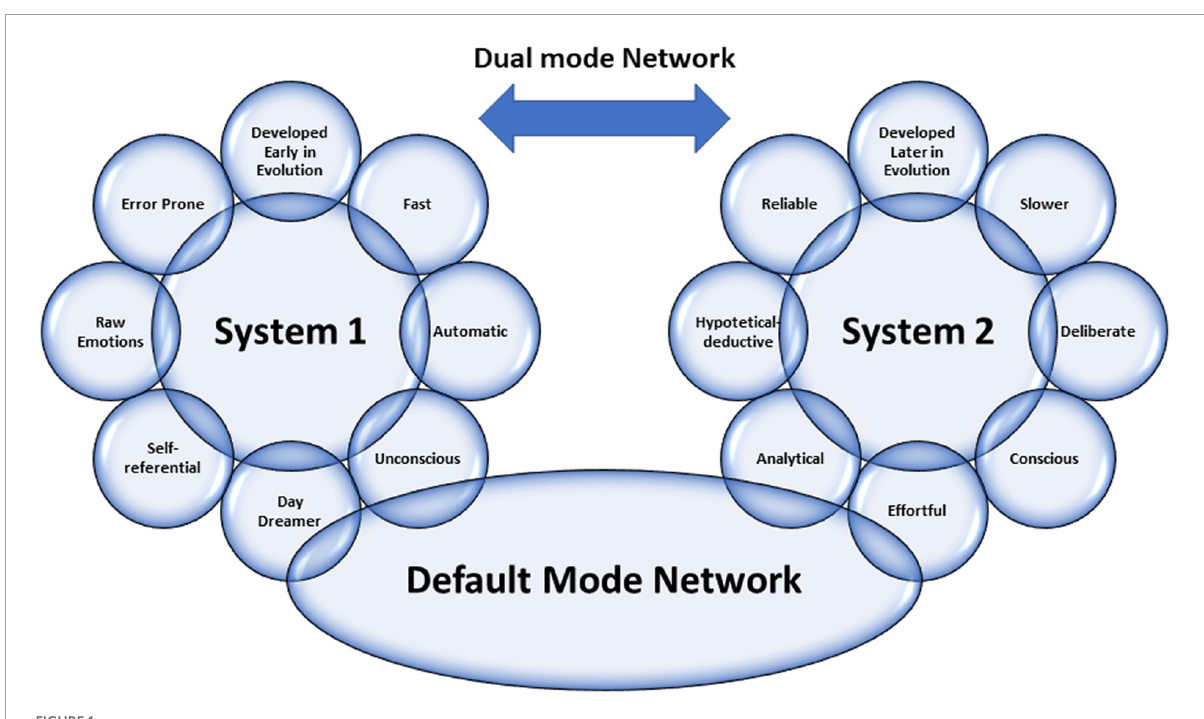
FIGURE1 Graphical representation of the characteristics of Dual Mode Network, including the relationship between the two systems by Default Mode Network (view the text for